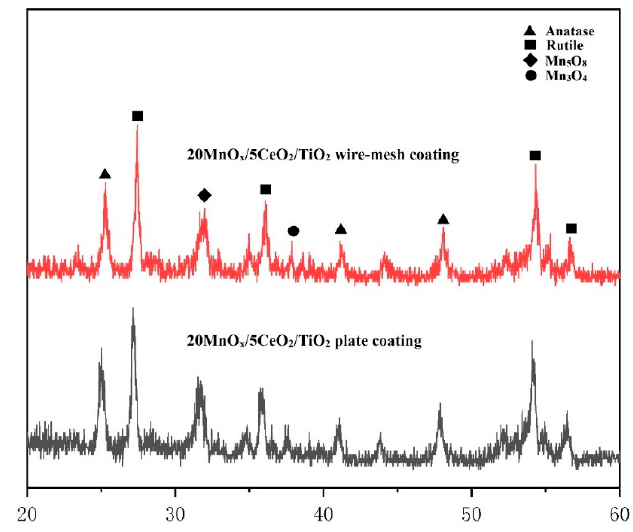
Figure 13. The XRD patterns of the wire-mesh coating compared with plate